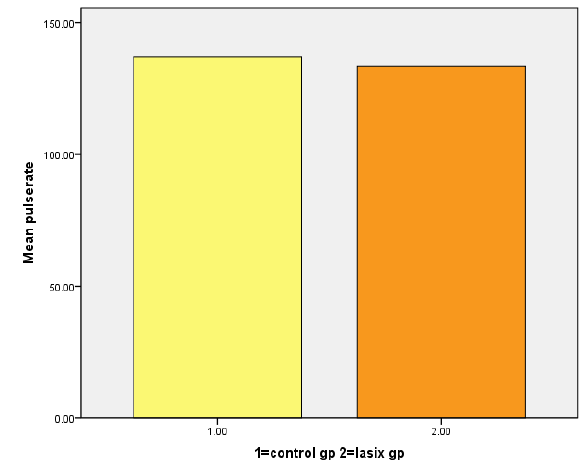
Figure (11A): Shocked patients received normal saline group versus shocked patients received furosemide group in term of pulse rate,there is significant statistical diffrence(p=0001).